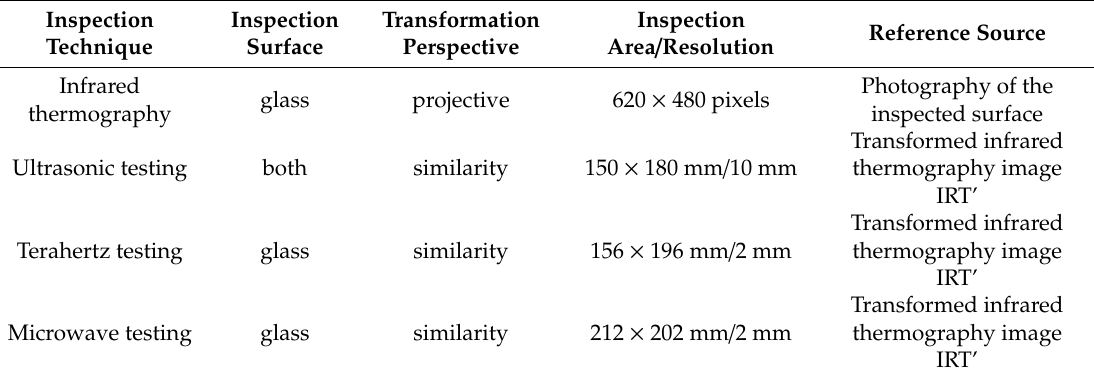
Table 1. Technical parameters of the inspection